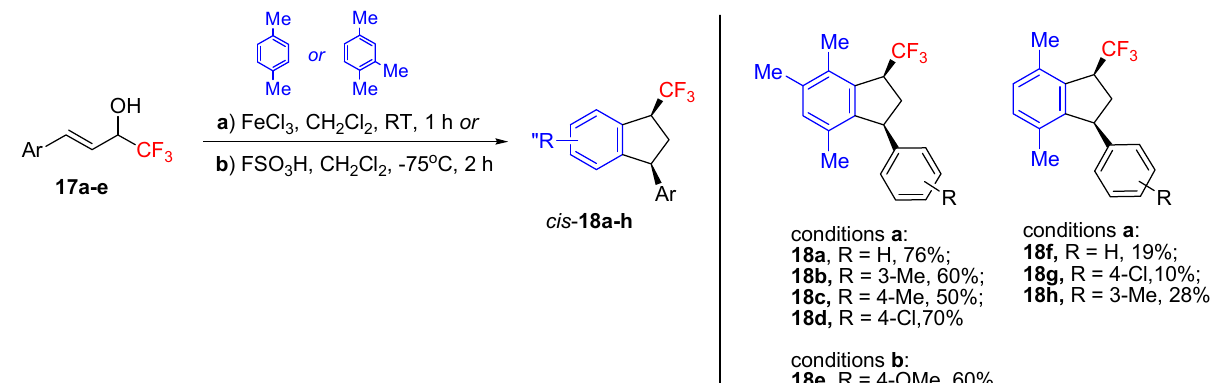
Scheme 11. Generation of species D and E ( E ′ ↔ E ″ ) from CF 3 -allyl alcohols 16 under the action of Brønsted or Lewis acids.